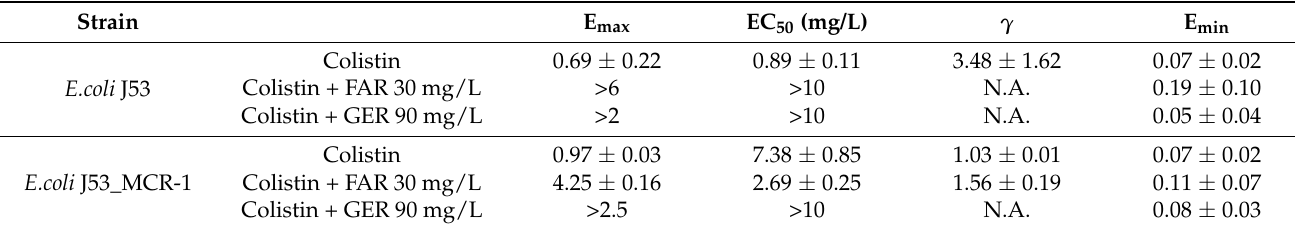
Table 4. E max model fitting parameters values estimated for curves representing PI relative uptake rate measured for E. coli J53 or E. coli J53_MCR-1 versus colistin alone or associated with 30 mg/L of FAR or 90 mg/L of GER. N.A.: not applicable. Strain